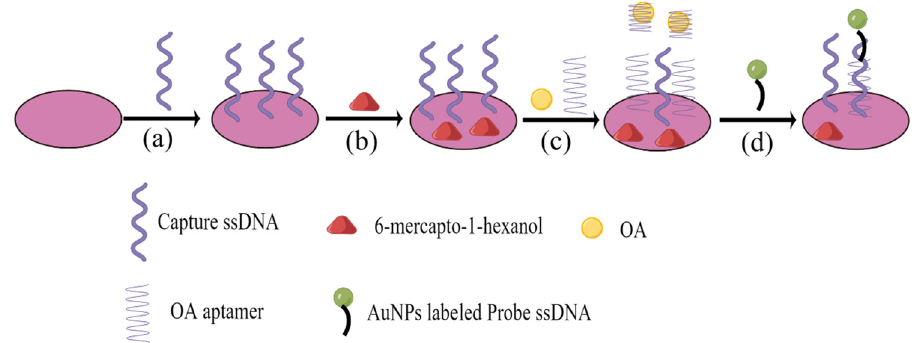
Figure 3: Detection principle of the aptamer - based sensors. The modi fi cation process of the sensor chip ( a and b ) and the detection process of OA ( c and d )